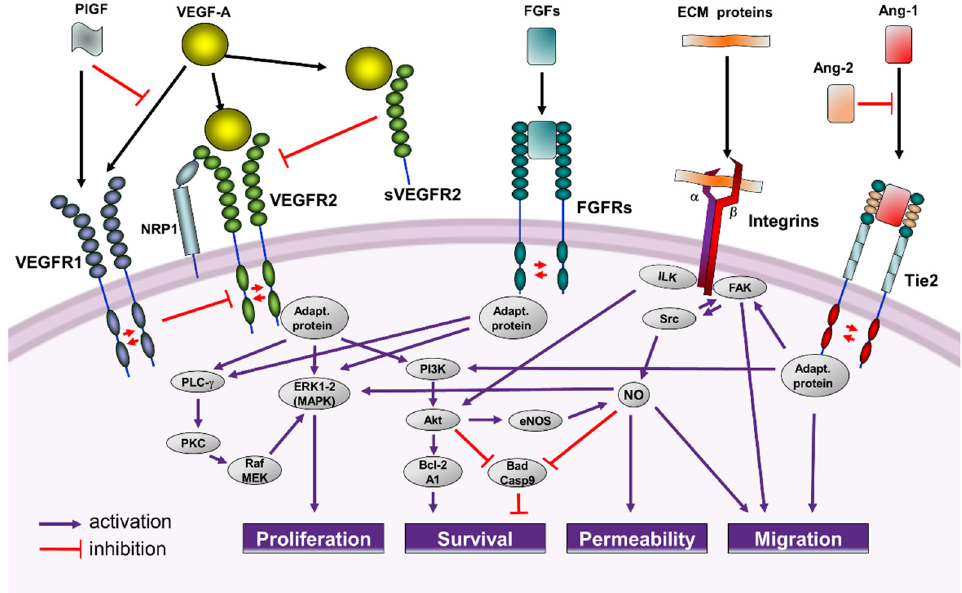
Figure 1. Molecular mechanisms of angiogenesis in activated endothelial cells. Ligand binding induces dimerization and autophosphorylation of tyrosine kinase receptors (VEGFR2, FGFRs, Tie-2). Receptor activation brings on the recruitment of several adaptor proteins that trigger signaling pathways leading to proliferation, migration, improved survival and loss of intercellular adhesions of endothelial cells.